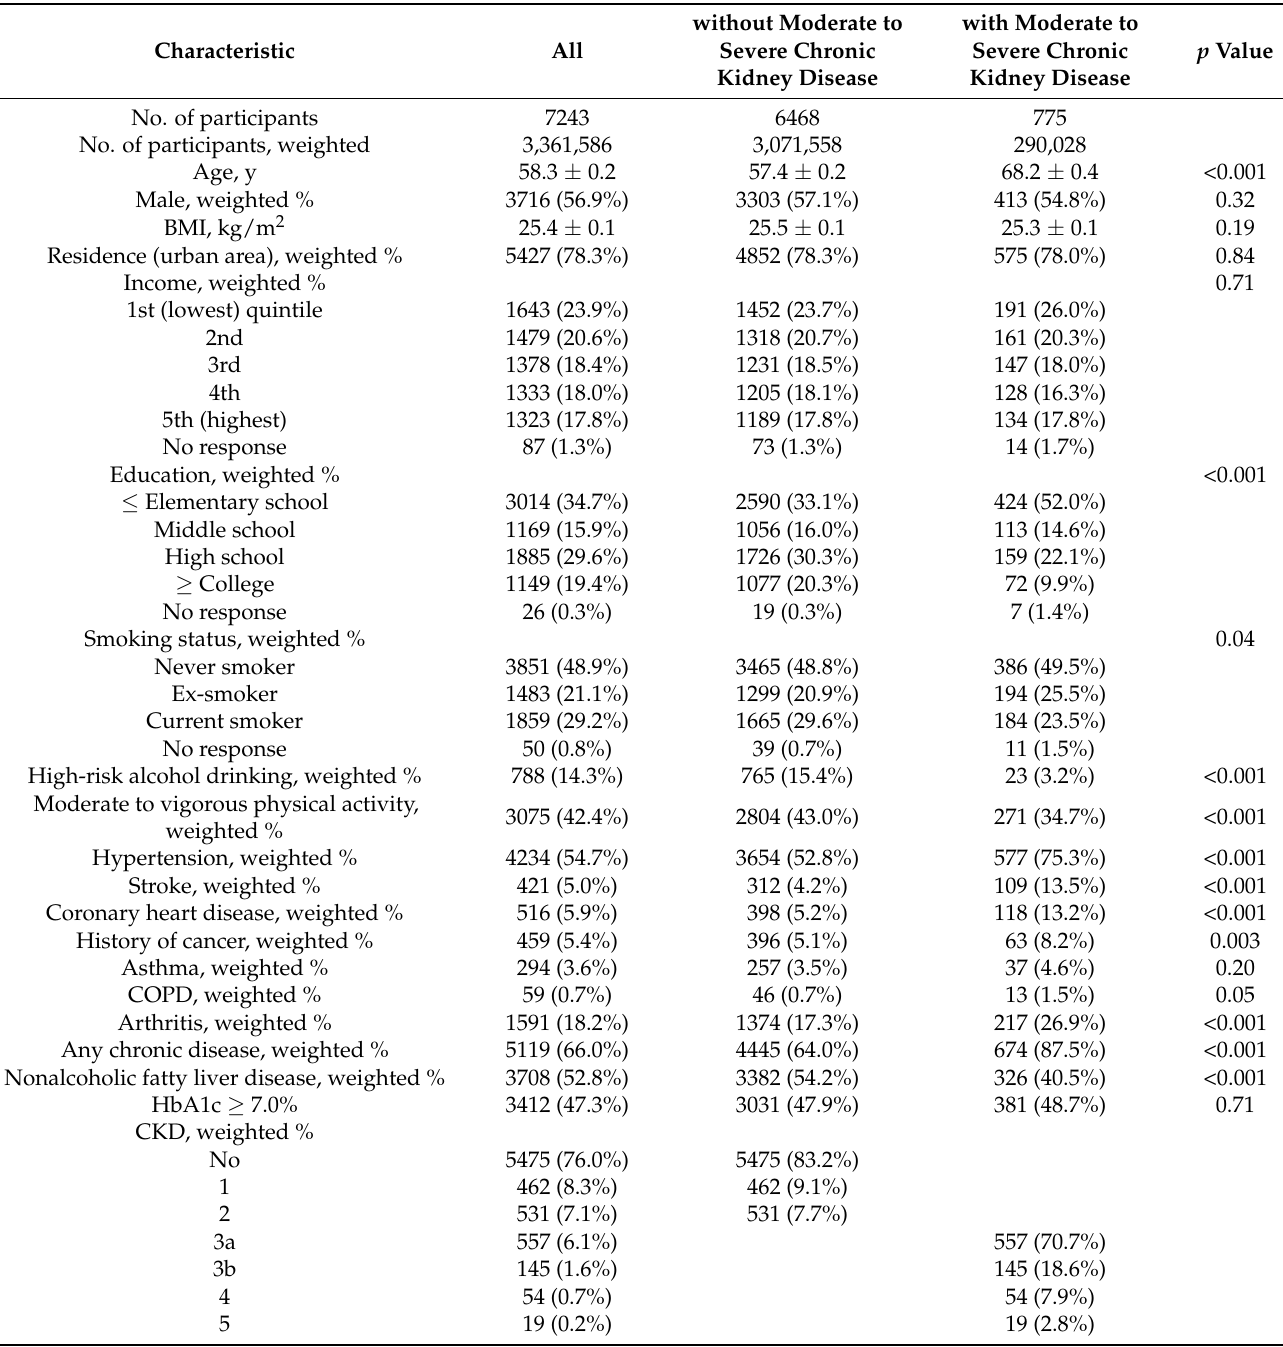
Table 1. Demographic and clinical characteristics of the study